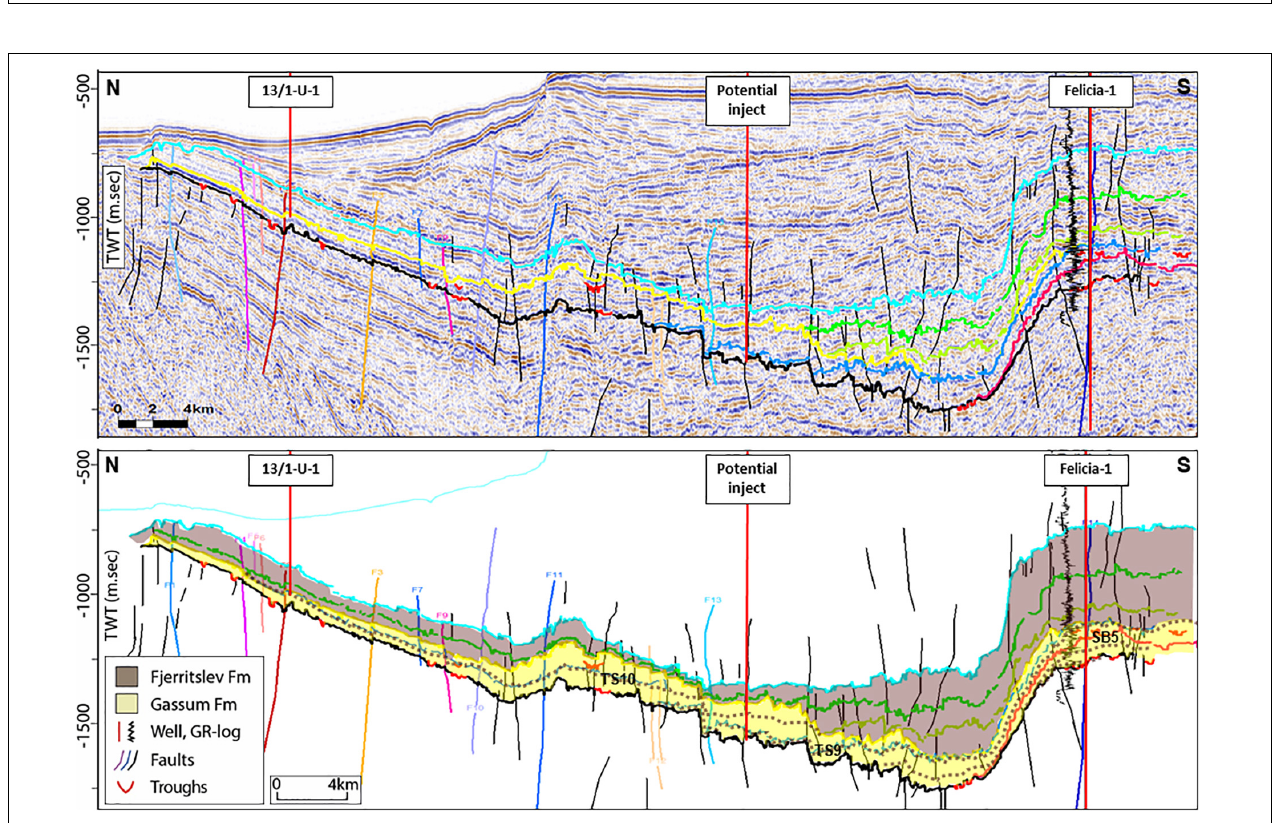
FIGURE 2 | Seismic profile from the Skagerrak showing that the Gassum Formation is sloping updip toward the north. The subtle troughs are possible channel structures. The 13/1-U-1 well and the potential injection site are projected (see Figure 1 ). The sequence boundary (SB5) and transgressive surfaces (TS9 and TS10) are interpreted in relation to the sequence stratigraphy by Nielsen (2003). The black faults are interpreted on this seismic profile only, whereas the colored faults tie between more seismic profiles. The northward onlapping internal seismic reflectors indicate that the lower part of the formation gradually disappears toward the basin